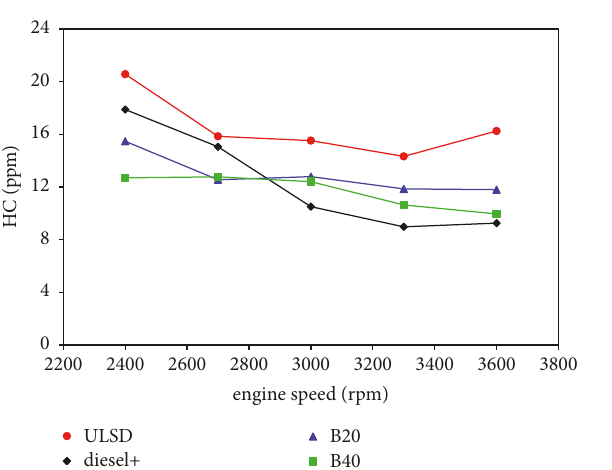
Figure 9: O 2 variation with engine speed at 80%